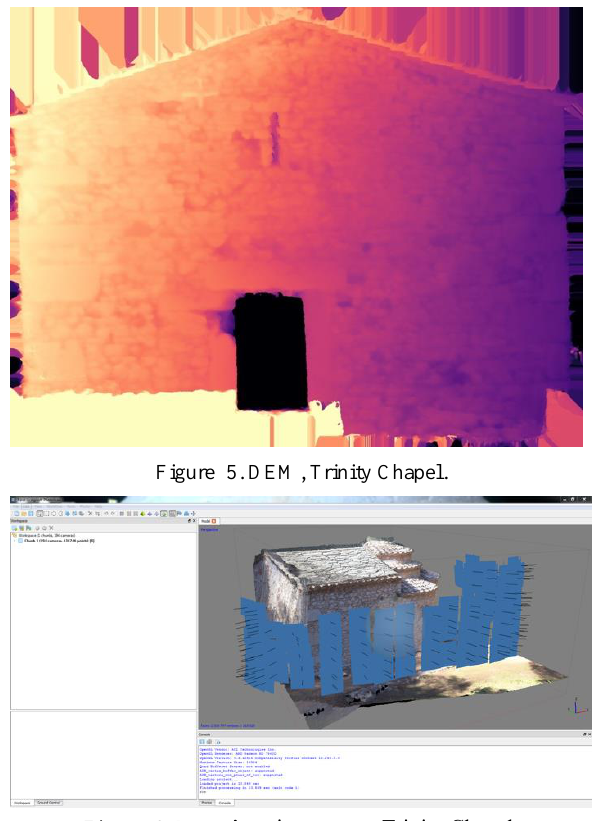
Figure 6. Drone’s strips system, Trinity